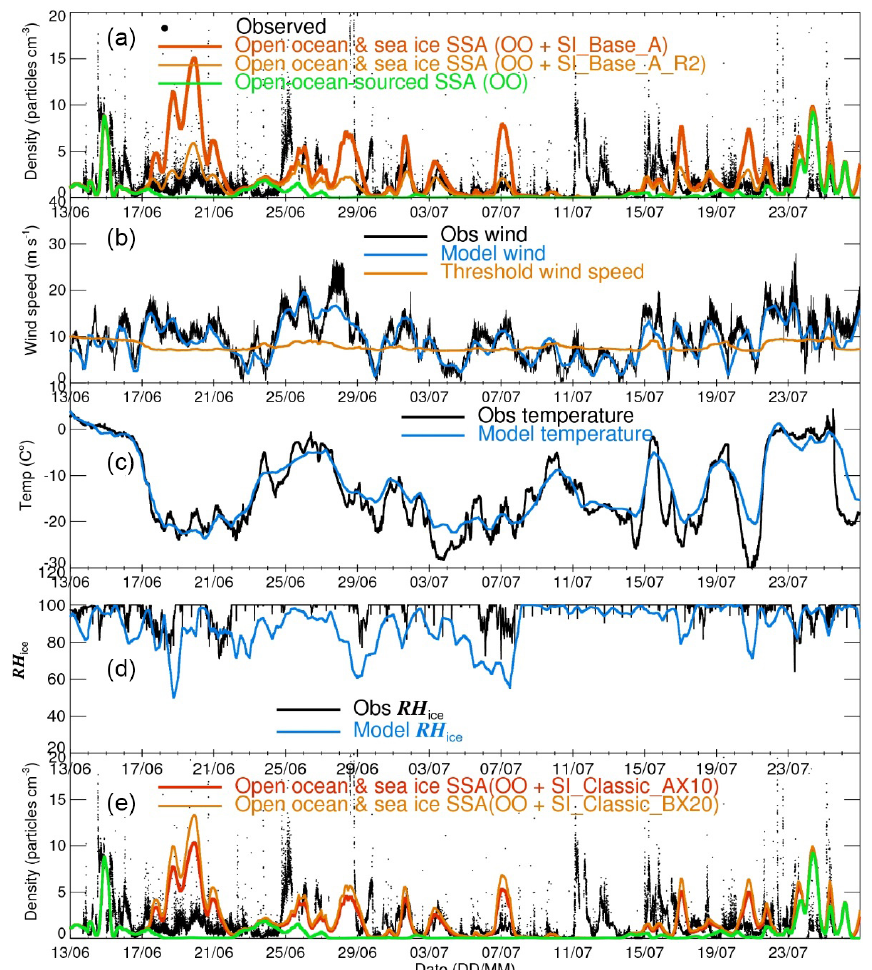
Figure 1. (a) Time series of total aerosol number densities from observations along the cruise track (refer to Fig. 1 in Frey et al., 2019) and model output of SI_Base_A (control run) and SI_Base_R2 (with a fixed surface RH with respect to ice equal to 95%). Note that only SSAs with sizes overlapping with the observation ( ∼ 0 . 4–12µm) are counted. Meteorological data of wind speeds (b) , temperatures (c) and relative humidity with respect to ice from both observation and model are shown. Calculated threshold wind speed for blowing snow is given in (b) . Panel (e) is the same as (a) , apart from the model output of SI_Classic_AX10 and